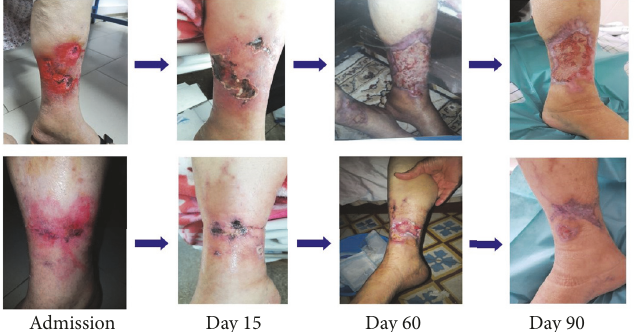
Figure 5: Evolution of Calciphylaxis lesions over 3 months of treatment in patient